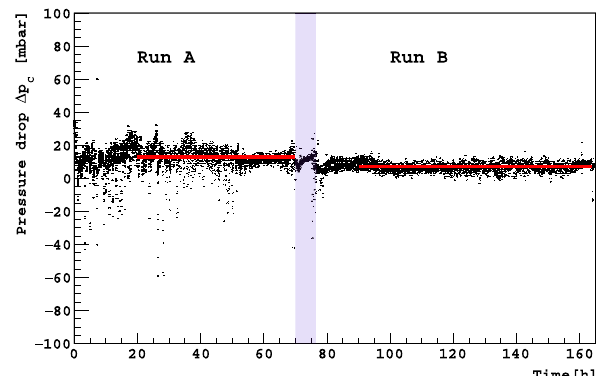
Fig. 15 Measuredpressure dropbetweencondenserandreboilerinthe column, Δ p C ,vstime,for 29 N 2 – 28 N 2 distillationintheprototype plant. TheredhorizontallinesindicatetheaveragepressuredropvaluesinRun A and Run B of 12 . 9 ± 5 . 4mbar and 6 . 9 ± 2 . 7mbar, respectively. The averages are taken only for time periods after the distillation transients of both runs are over, as observed in Fig.